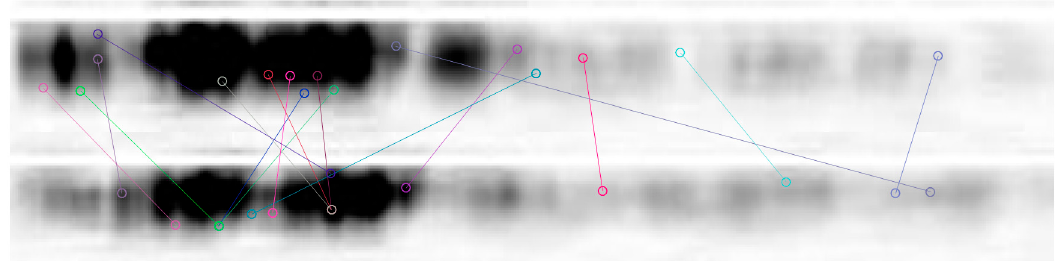
Figure 9. Comparison of two indexes under different weight.